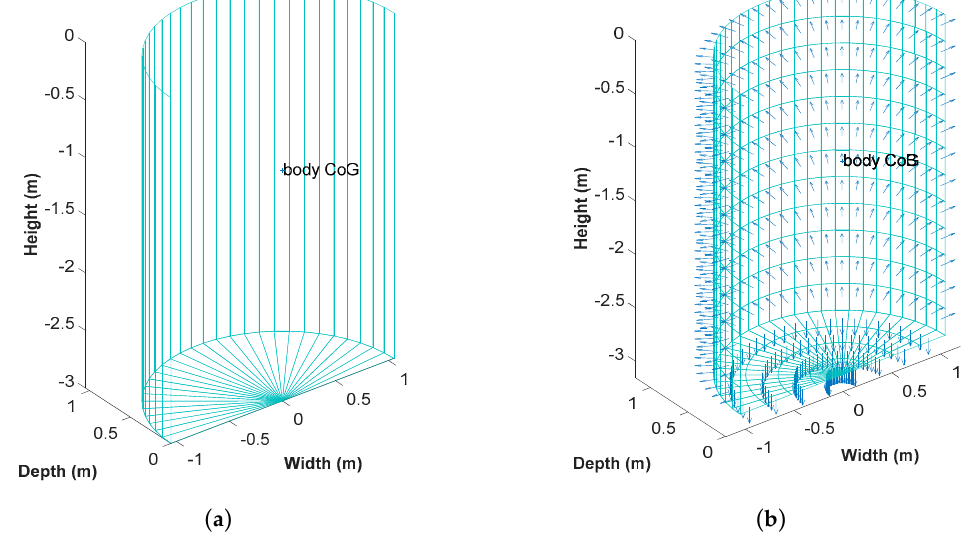
Figure 3. Mesh design for the submerged part of a cylindrical buoy generated by EWST to perform NEMOH hydrodynamic simulation. ( a ) NEMOH mesh of the cylindrical buoy. The center of gravity (CoG) is visible; ( b ) Refined mesh of the cylindrical buoy with the normal pointing out. The center of buoyancy (CoB) is visible.